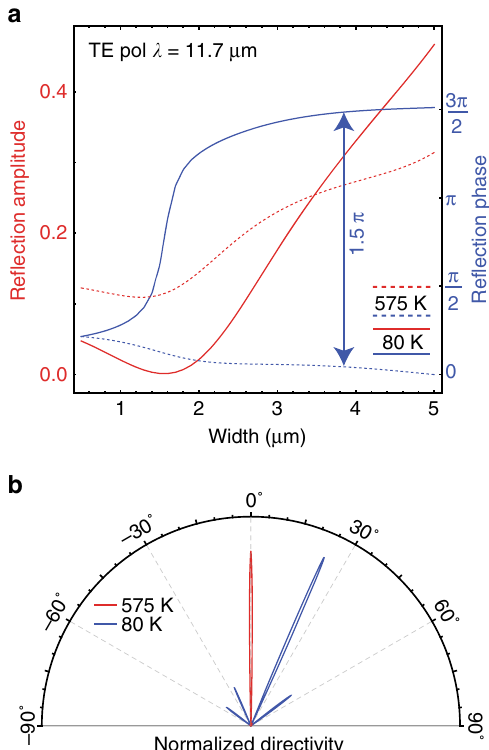
Fig. 5 Thermal beam-steering metasurface. a Width-dependent re fl ection amplitude ( red , left axis ) and phase ( blue , right axis ) from a periodic array (6 μ m periodicity) of 1 μ m tall InSb wires at a wavelength of 11.7 μ m. At 575 K ( dashed ) the phase is nearly constant with width. Due to pinning of the TE resonances, this evolves into a 3 π /2 size-dependent phase variation at 80 K ( solid ) b Using these phase functions, a recon fi gurable metasurface can be designed with normal incidence re fl ection at 575 K ( red ) and a unidirectional diffraction lobe at 80 K ( blue ). The polar plot shows the normalized directivity of the (10 unit cell) metasurface which re fl ects a normally incident light towards 25° at 80 K ( blue ) and 0° at 575 K ( red